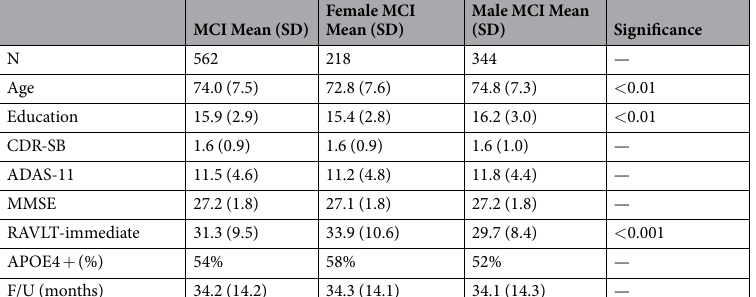
— Table 1. Baseline Demographic and Clinical Variables. ADAS = Alzheimer’s Disease Assessment Scale Cognitive Subscale Total Score; CDR-SB = Clinical dementia Rating Sum of Boxes; MMSE = Mini-Mental State Exam total score; RAVLT = Rey Auditory Verbal Learning Test; F/u = follow up duration averaged between the two studies; P-values are for comparison of male versus female